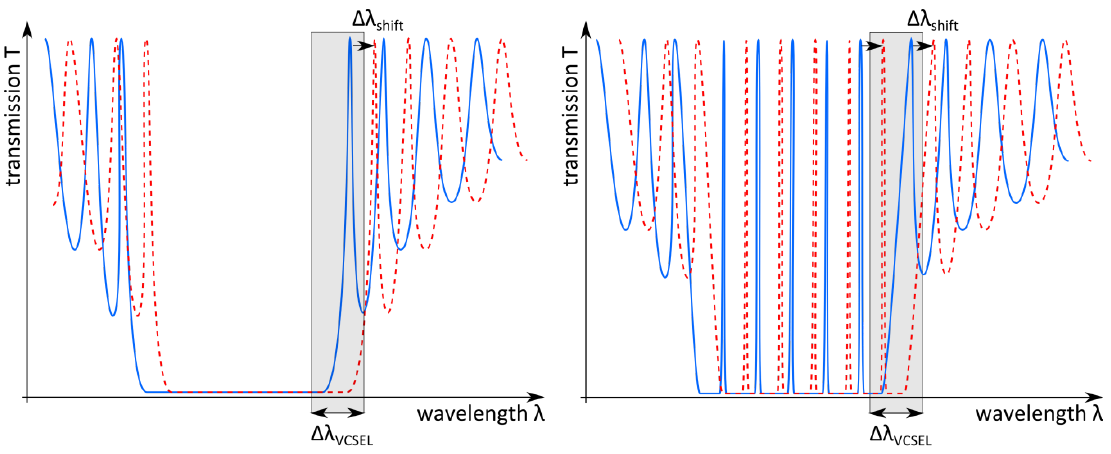
Figure 6. The additional resonance peaks within the stop-band help to bridge the 2 nm tuning range of the VCSEL laser ∆λ VCSEL increase the transducers dynamic range and ease the fabrication tolerances. Whereas large spectral shifts ∆λ shift may not be measured with the Bragg grating reflector since the peak shifts out of the detection window ( left ), an adjacent peak appears in the lasers’ tuning range in case of the Bragg grating resonator ( right